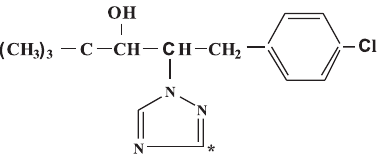
Figura 1. Estrutura química do paclobutrazol e localização da marcação com 14 C